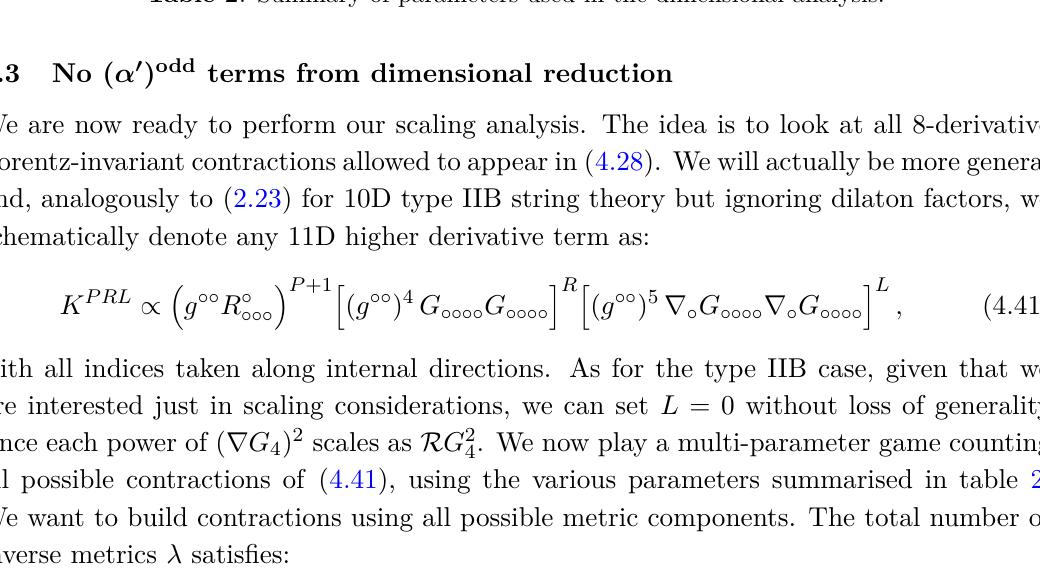
Table 2 . Summary of parameters used in the dimensional